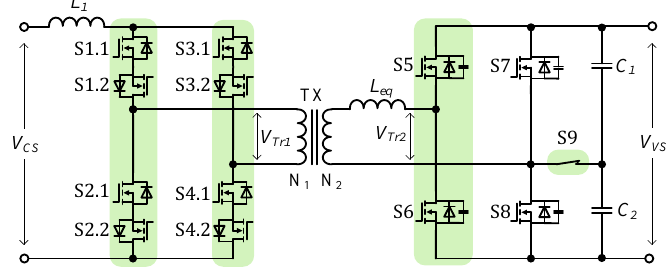
Figure 1. Analyzed PS-SMC converter topology with a reconfigurable rectifier.